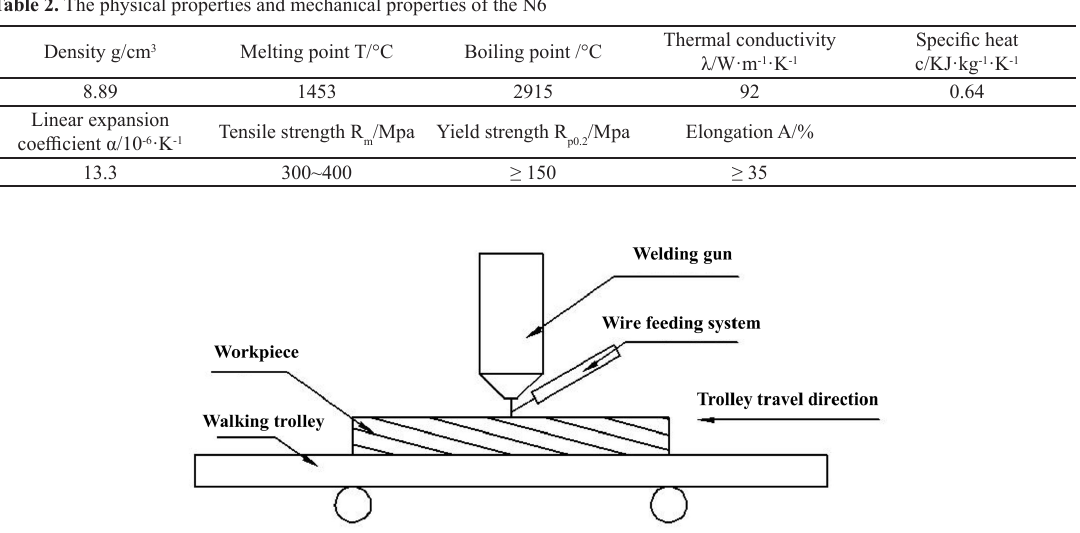
Figure 1. Schematic diagram of welding